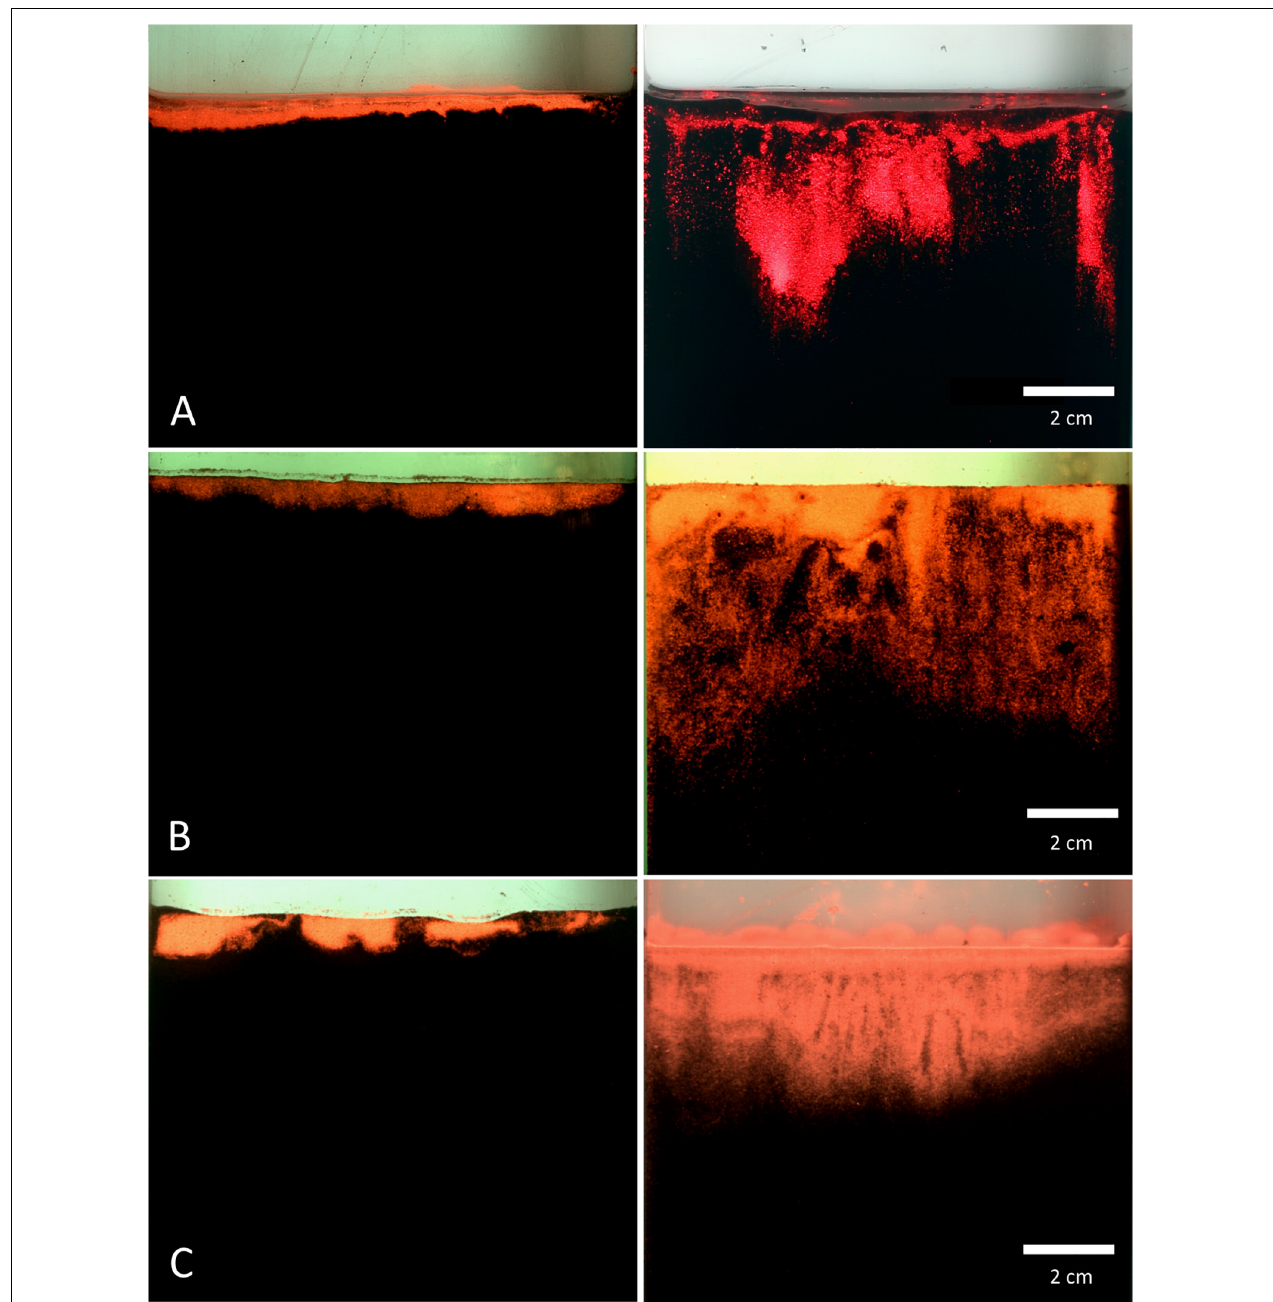
FIGURE 7 | Pictures of the luminophore smearing directly at the inserted plate for control (left) and penetration (right) treatments. (A) mud and sand-like luminophores, (B) fine sand and sand-like luminophores, and (C) medium sand and mud-like luminophores. Image colours are digitally enhanced to simplify